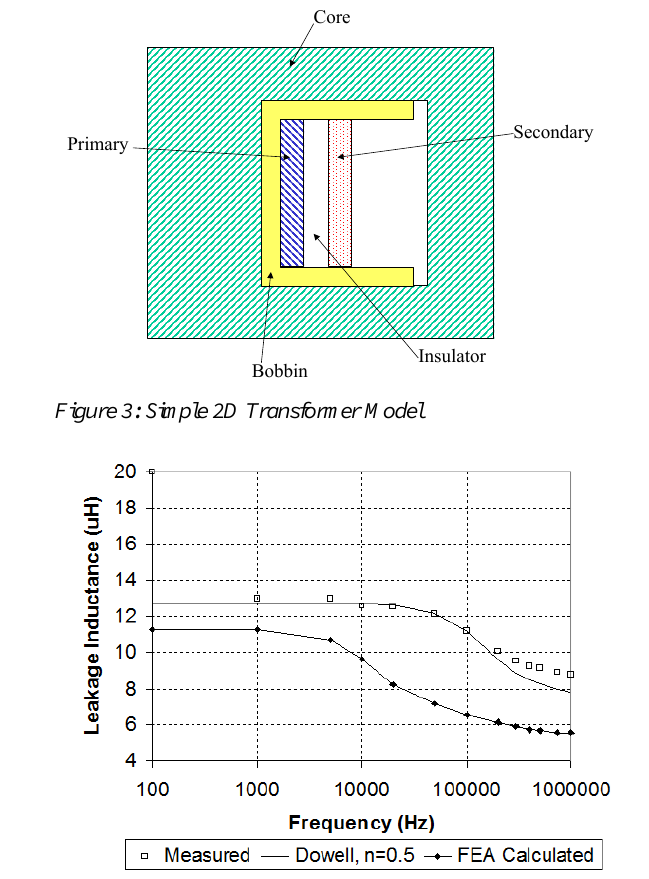
Figure 4: Simple 2D Finite Element